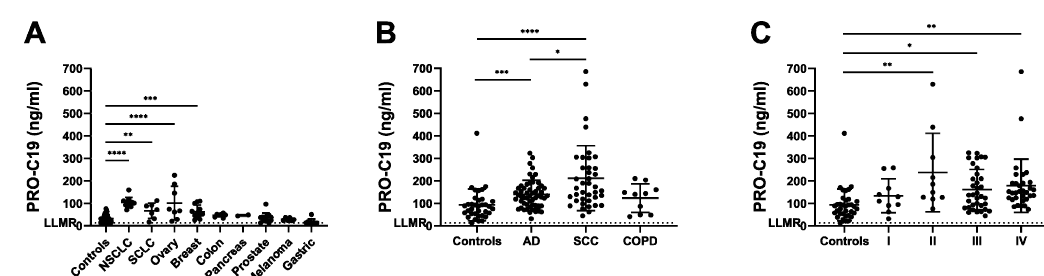
Figure 3. PRO-C19 in cohort 1 (A) and 2 (B and C). Quantification of PRO-C19 in the serum of: ( A) healthy controls ( n = 38) and a range of cancer types including NSCLC ( n = 11), ovary ( n = 8), SCLC ( n = 7), breast ( n = 12), colon ( n = 7), pancreas ( n = 2), prostate ( n = 13), melanoma ( n = 6), gastric ( n = 9). ( B ) healthy controls ( n = 35), AD ( n = 55), SCC ( n = 39) and COPD ( n = 10). ( C ) healthy controls ( n = 35), stage I ( n = 10), stage II ( n = 10), stage III ( n = 35) and stage IV ( n = 32). PRO-C19 levels are presented with mean and standard deviation. Samples measuring below the lower limit of measurement range (LLMR) were given the value of the LLMR, as determined in the validation of PRO-C19. Di ff erences in PRO-C19 levels were evaluated by log-transforming the data and performing ordinary one-way ANOVA corrected for multiple comparisons with Tukey test. **** indicates a p -value below 0.0001. *** indicates a p -value below 0.001. ** indicates a p -value below 0.01. * indicates a p -value below 0.05.